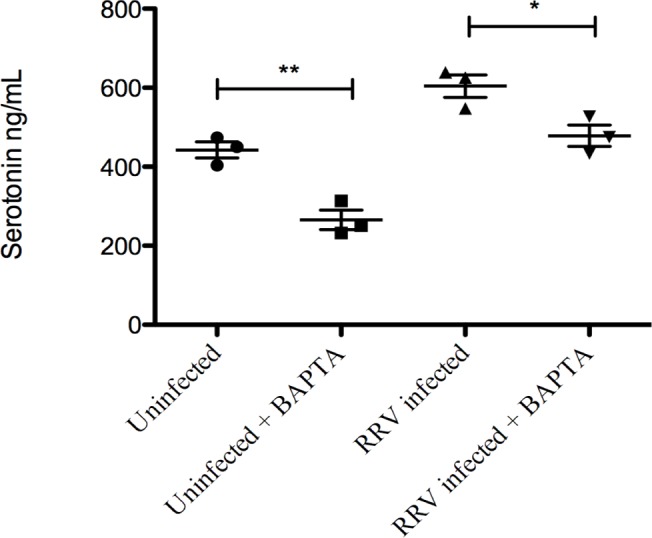
Release of serotonin from rotavirus-infected EC tumor cells is a calcium-dependent process.EC tumor cells were first infected with RRV (MOI = 0.5) and then at 3 h p.i BAPTA/AM was added to the cells to quench Ca2+ signals and 7 h p.i cell medium was collected for further serotonin ELISA assessment. Data is presented as means ± SEM. * = p ˂ 0.05 and ** = p ˂ 0.01 with Student’s t-test; n = 3.